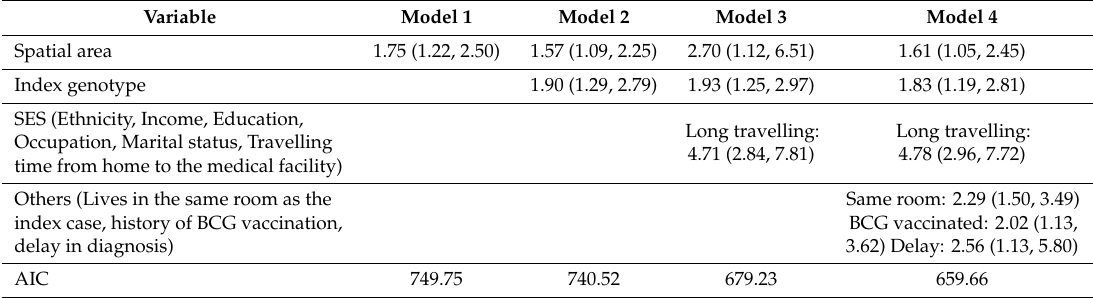
Table 5. Results of multivariate analysis of factors associated with tuberculin skin test result (aOR 95%